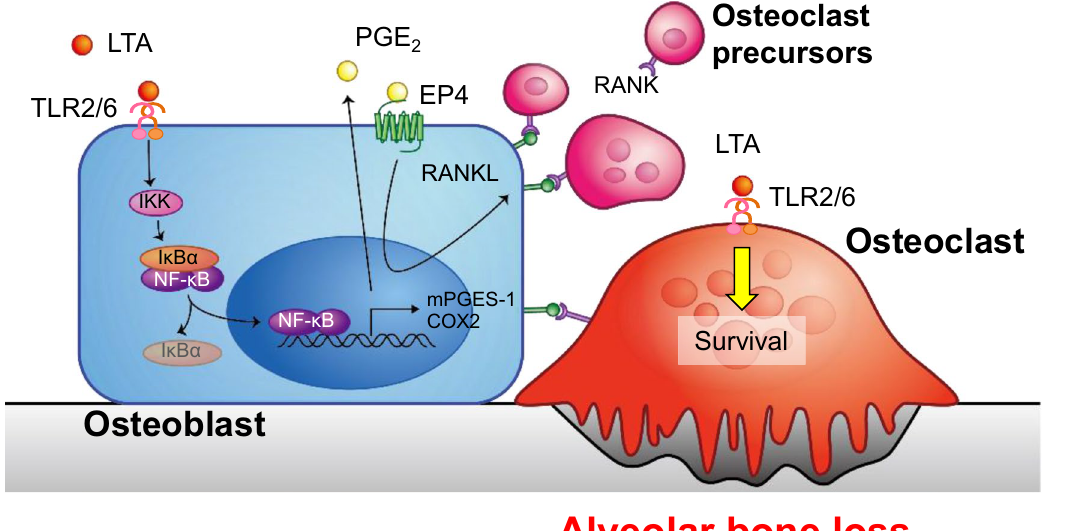
Figure 7. The model illustrates the effects of LTA on osteoblast and osteoclast in periodontal bone resorption. LTA induced the PGE 2 -mediated expression of RANKL in osteoblasts and directly promoted the cell survival of mature osteoclasts, leading to alveolar bone loss in